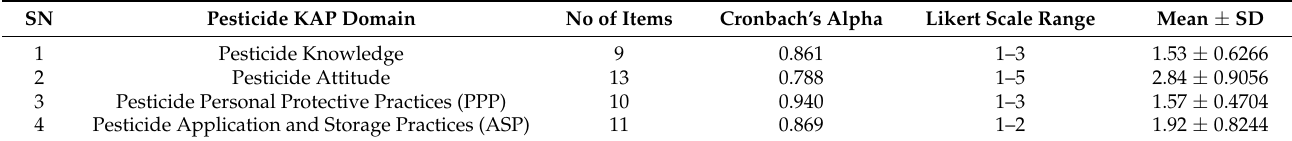
Table 1. Pesticide Knowledge, Attitude, and Practice Domains: Reliability and